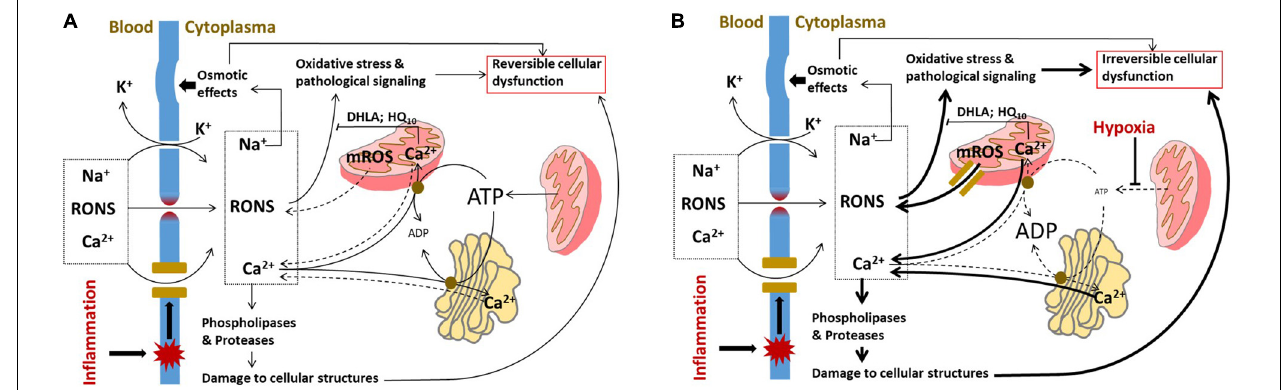
FIGURE 2 | Induction of cellular dysfunction occurring due to damage to cellular membranes. (A) Pathologic mechanisms operating in parenchymal cells upon damage to plasma membrane. The influx of RONS and Ca 2 + through the defects in plasma membrane is partially compensated by intracellular organelles, which scavenge RONS and take up Ca 2 + from the cytoplasm by ATP-dependent Ca 2 + pumps. In addition, the influx of Na + and leak of K + are compensated by Na + /K + pump, which uses ATP to pump the ions (not shown). At this phase of disease, the cells are exposed to oxidative stress, osmotic shock, and elevated activities of phospholipases and proteases; however, all these changes are still reversible because if sources of damaging substances in the blood are removed, the plasma membrane will be repaired and the functional intracellular organelles will restore the normal cellular metabolism. (B) Pathologic mechanisms operating in parenchymal cells upon damage to plasma membrane combined with damage to intracellular compartments induced by hypoxia. Under hypoxic conditions, the ATP levels in cells are drastically decreased and all the ATP-dependent processes are slowed down. The mitochondria instead of taking up Ca 2 + and scavenging RONS will release Ca 2 + and RONS; the latter leak through permeability transition pore, an intracellular PFP formed in mitochondria. The pathological changes in ion homeostasis are decompensated and Na + /K + imbalance will be further aggravated. The cell comes in a kind of decompensation phase and the cellular dysfunction will become irreversible. RONS, reactive oxygen and nitrogen species; DHLA, dihydrolipoic acid; HQ 10 , ubiquinone; and mROS, mitochondrial reactive oxygen